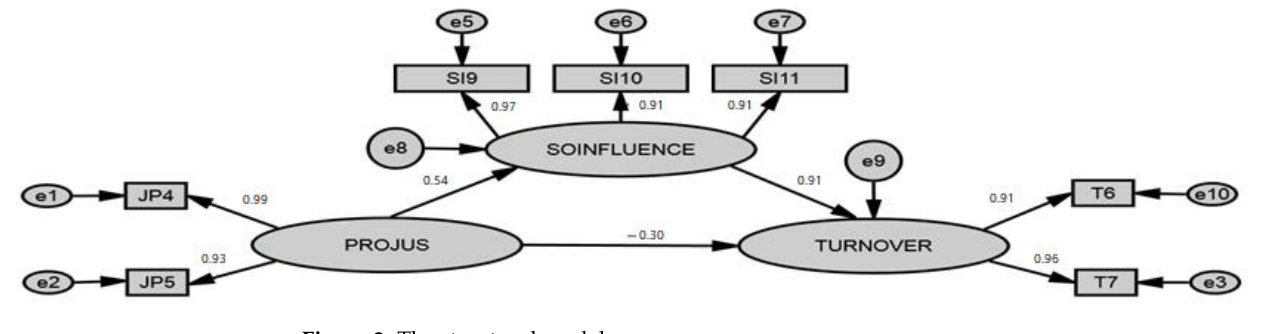
Figure 2. The structural model.